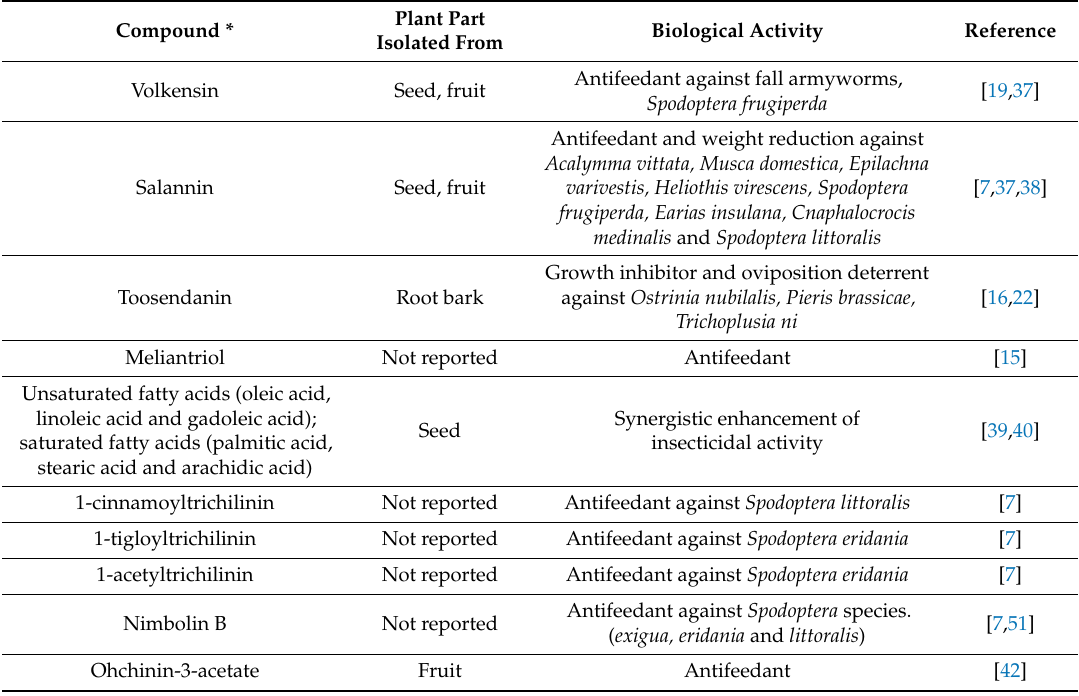
Table A2. Phytochemical investigation of Melia volkensii